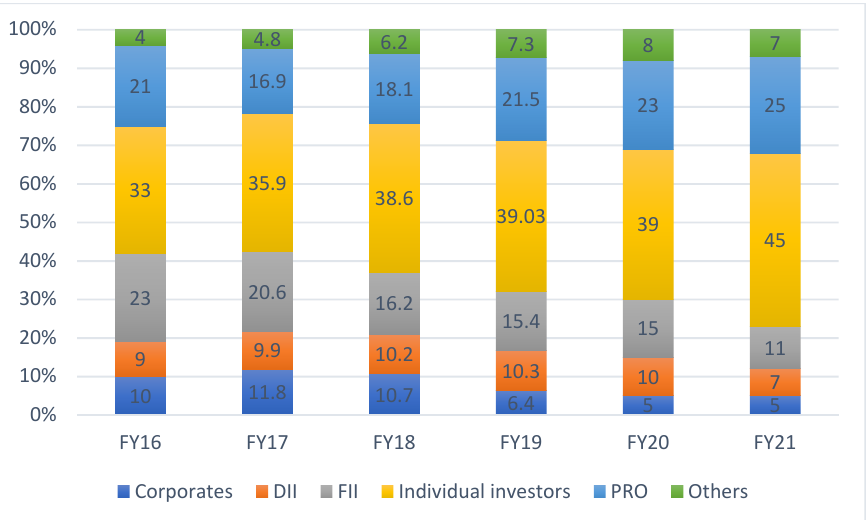
Figure 1. Share of client participation in the capital market at National Stock Exchange (NSE) India.